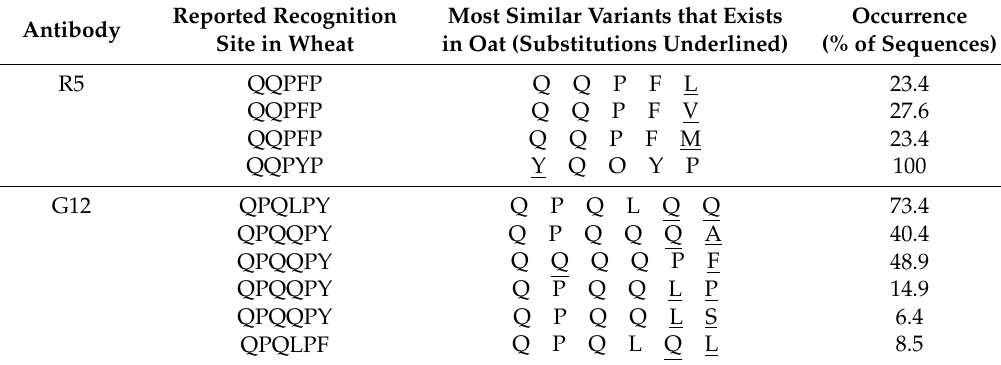
Table 2. Variants of the recognition sites of the R5 and G12 antibodies with one and two amino acid substitutions in oat avenins. No perfect recognition sites were present in avenin gene sequences of 13 Avena species (adapted from Londono et al.